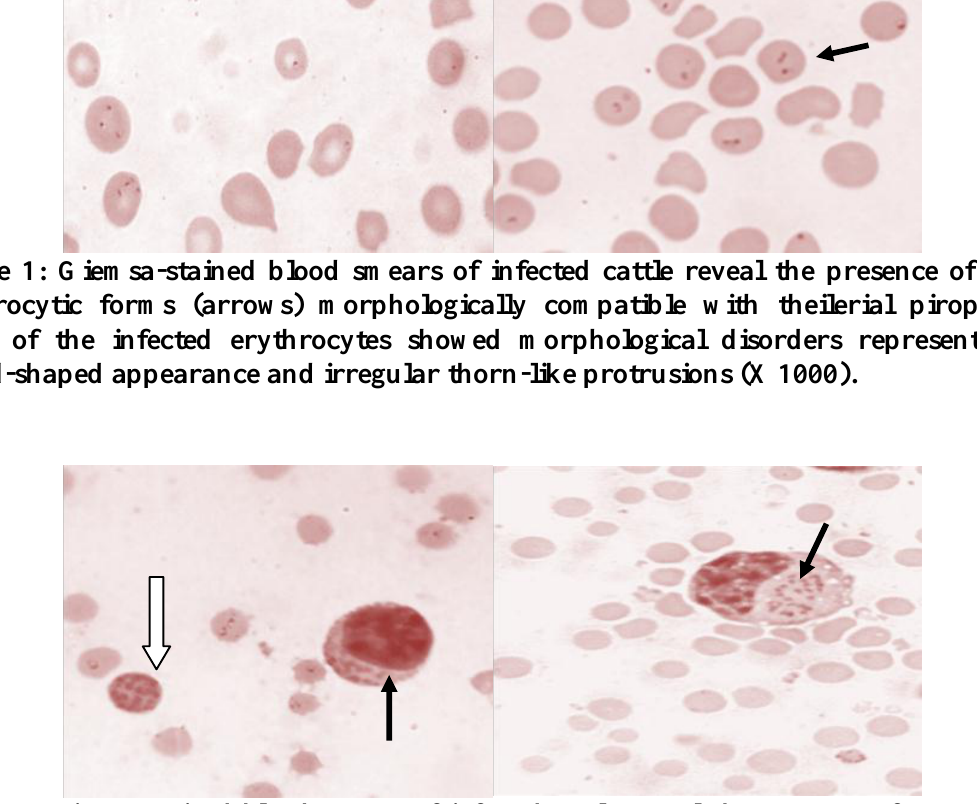
Figure 2: Giemsa-stained blood smears of infected cattle reveal the presence of extracellular (white arrow) and intracellular (black arrows) schizont forms of Theileria annulata parasites. Intra-erythrocytic piroplasm forms are also evident (X 1000).